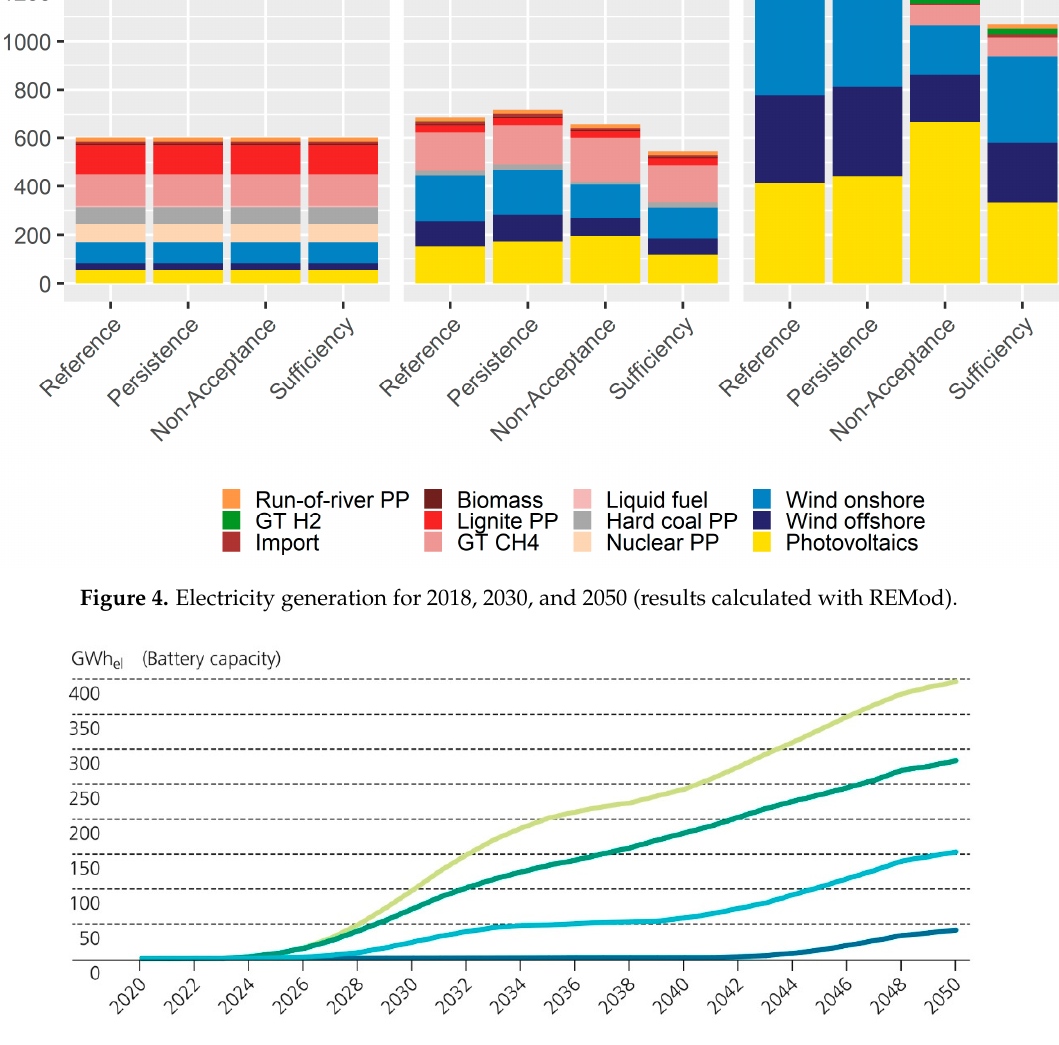
Figure 4. Electricity generation for 2018, 2030, and 2050 (results calculated with REMod).